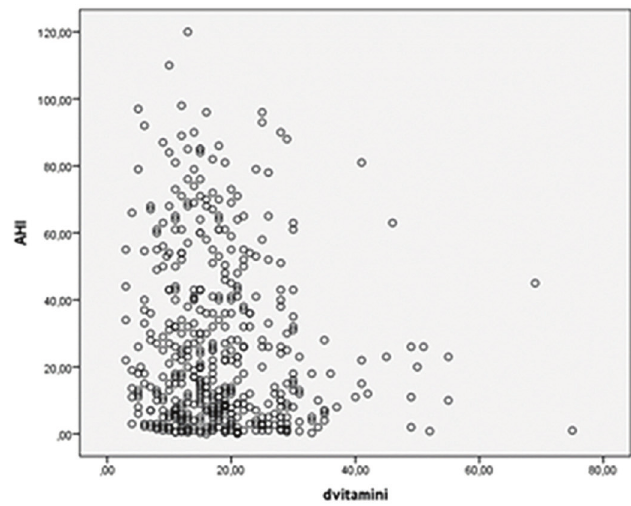
p:Multiple Binary Logistic Regression Figure 1 - Correlation of serum vitamin D level with apnea- hypopnea index (AHI) in all